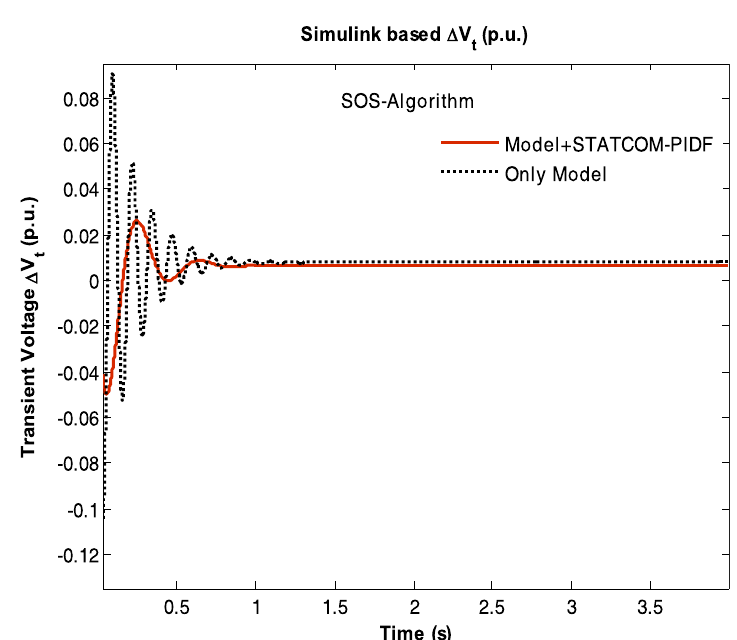
Fig. 8 Comparison of transient voltage response of the HPSM with and without controller for V = 0.99 p.u. and Xeq = 1.08 p.u